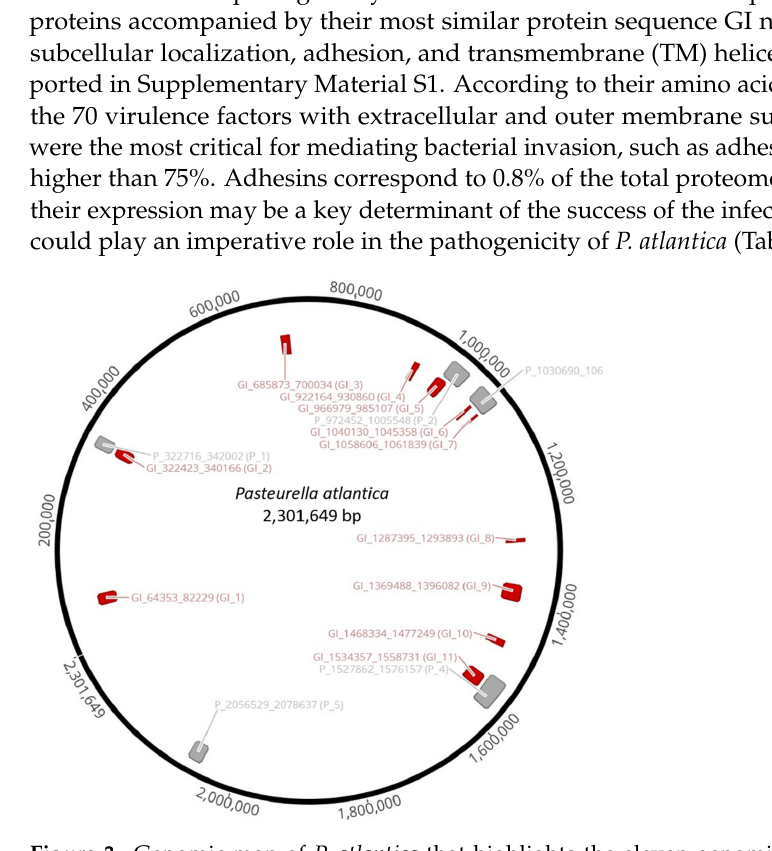
Figure 3. Genomic map of P. atlantica that highlights the eleven genomic islands ( red ) and five prophages ( grey ). Five out of eleven GIs are shown to overlap with four out of five prophages.